Question: Describe this figure in one sentence.
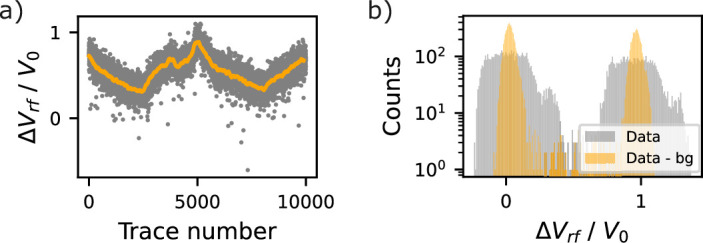
Answer: Classification using the HMM. a , Recall (proxy to readout fidelity) for each state as a function of the readout time, using the HMM to model the data and to classify traces at V GTB2 = 212 mV. When \documentclass[12pt]{minimal} \usepackage{amsmath} \usepackage{wasysym} \usepackage{amsfonts} \usepackage{amssymb} \usepackage{amsbsy} \usepackage{mathrsfs} \usepackage{upgreek} \setlength{\oddsidemargin}{-69pt} \begin{document}$${t}_{{\rm{read}}}\ll {\varGamma }_{{{\rm{T}}}_{0}}^{-1}$$\end{document} t i n t ≪ Γ T 0 − 1 (light green region), the recall of |T − 〉 and |S〉 improves as the readout time increases because noise averages out, while unrelaxed |T 0 〉 is misidentified as |T − 〉. Once \documentclass[12pt]{minimal} \usepackage{amsmath} \usepackage{wasysym} \usepackage{amsfonts} \usepackage{amssymb} \usepackage{amsbsy} \usepackage{mathrsfs} \usepackage{upgreek} \setlength{\oddsidemargin}{-69pt} \begin{document}$${t}_{{\rm{read}}}\ge {\varGamma }_{{{\rm{T}}}_{0}}^{-1}$$\end{document} t read ≥ Γ T 0 − 1 (purple region), |T 0 〉 becomes distinguishable from |T − 〉, improving recall for both triplets. Finally, for \documentclass[12pt]{minimal} \usepackage{amsmath} \usepackage{wasysym} \usepackage{amsfonts} \usepackage{amssymb} \usepackage{amsbsy} \usepackage{mathrsfs} \usepackage{upgreek} \setlength{\oddsidemargin}{-69pt} \begin{document}$${t}_{{\rm{read}}}\gg {\varGamma }_{{{\rm{T}}}_{-}}^{-1}$$\end{document} t read ≫ Γ T − − 1 (grey region), all triplet states have decayed and the recall plateaus because no extra information remains. b , c , Readout fidelity from the HMM-based classifier (solid lines) compared with the threshold classifier (dashed lines). b , Parity readout (labelled P). The HMM outperforms the threshold method when \documentclass[12pt]{minimal} \usepackage{amsmath} \usepackage{wasysym} \usepackage{amsfonts} \usepackage{amssymb} \usepackage{amsbsy} \usepackage{mathrsfs} \usepackage{upgreek} \setlength{\oddsidemargin}{-69pt} \begin{document}$${t}_{{\rm{r